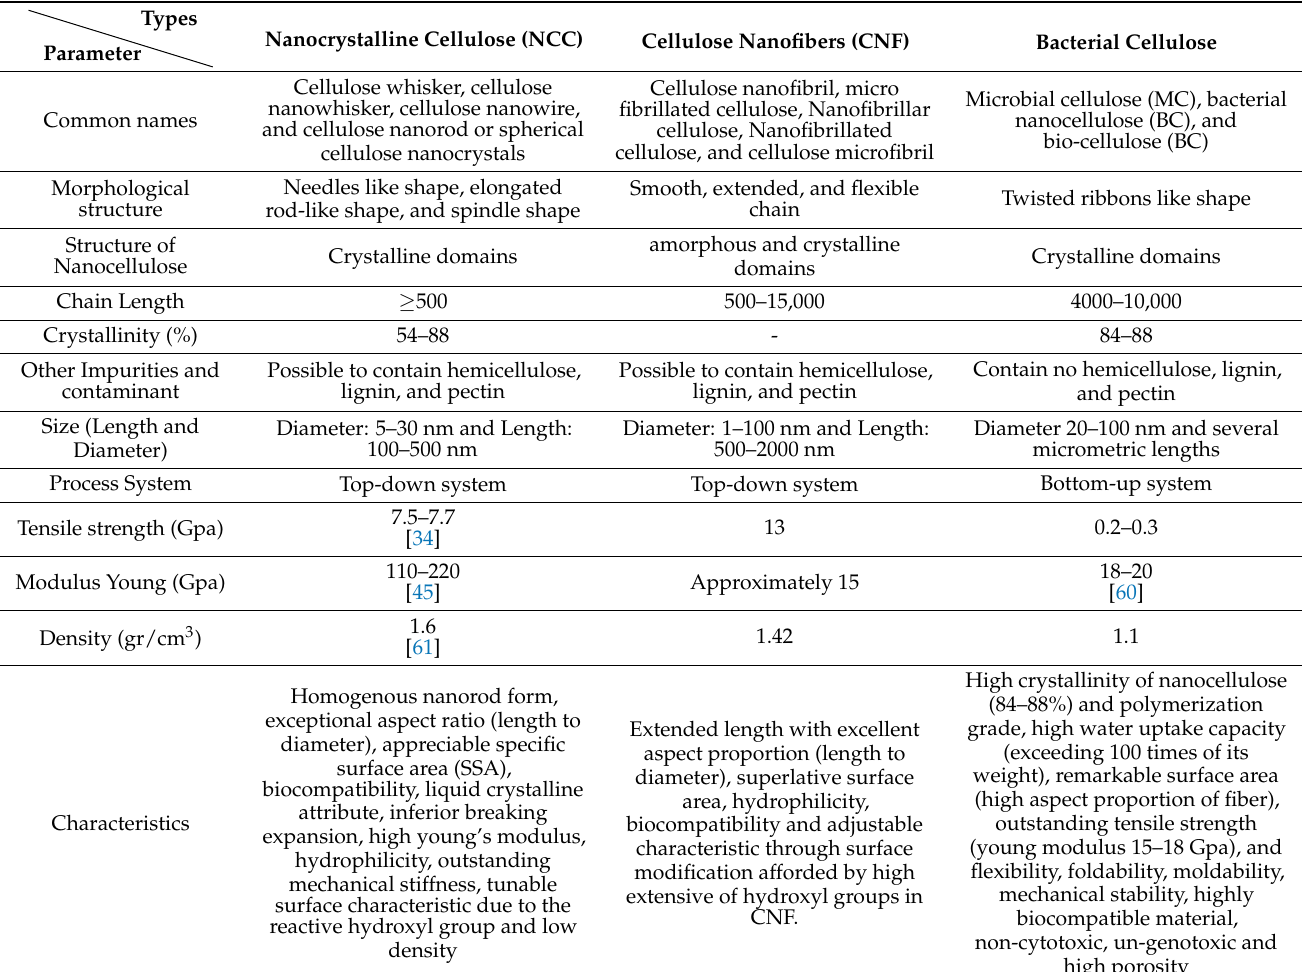
Table 1. Summary of the characteristics of various types of